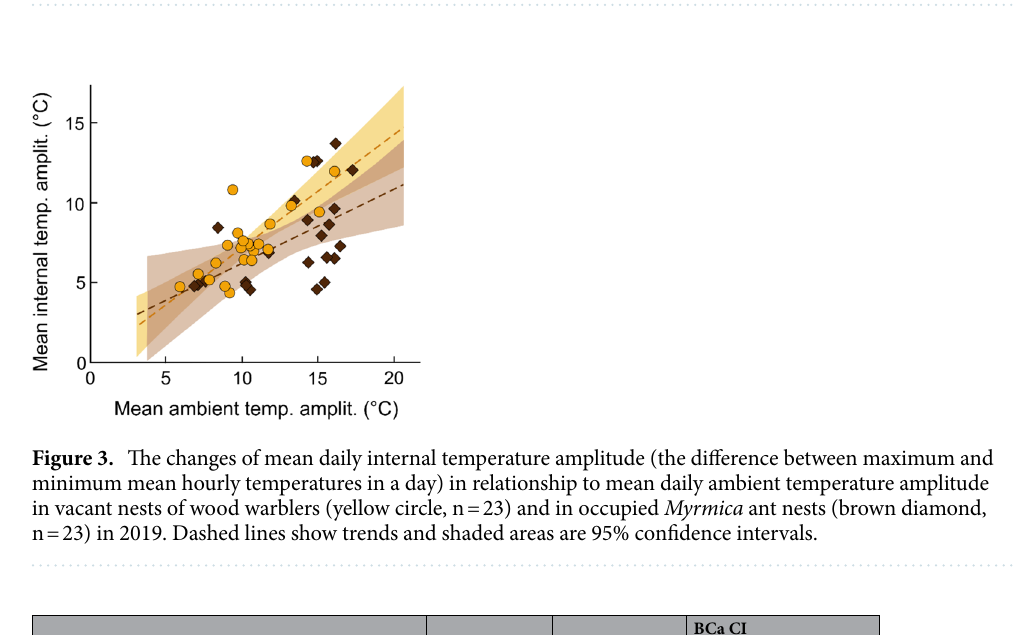
Table 2. Results of bootstrapped (2000 replications) linear regression showing the changes of mean daily internal temperature (response variable) with main effects of the respective ambient temperature and nest type (wood warbler nests containing incubated eggs, or nestlings of a median 7 days old, vs. Myrmica ant nests). The presented regression coefficients were used to calculate the predicted temperatures shown in Fig. 2. The statistically significant results are highlighted with bold font. Bias-corrected and accelerated bootstrap confidence intervals (BCa CI) are shown.